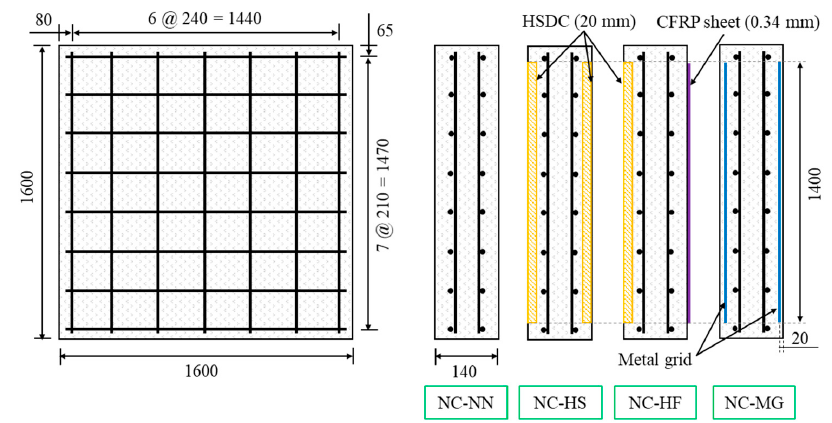
Figure 7. Details of specimens.